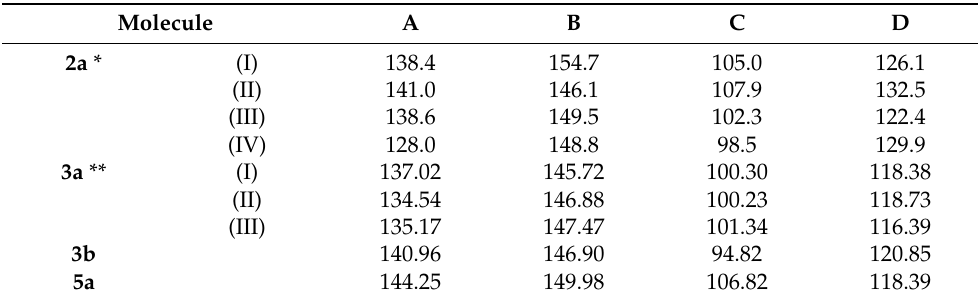
* Four crystallographically independent molecules in the asymmetric unit; ** Three crystallographically independent molecules in the asymmetric unit. See Figure 5 for description of aryl rings A, B, C and D.